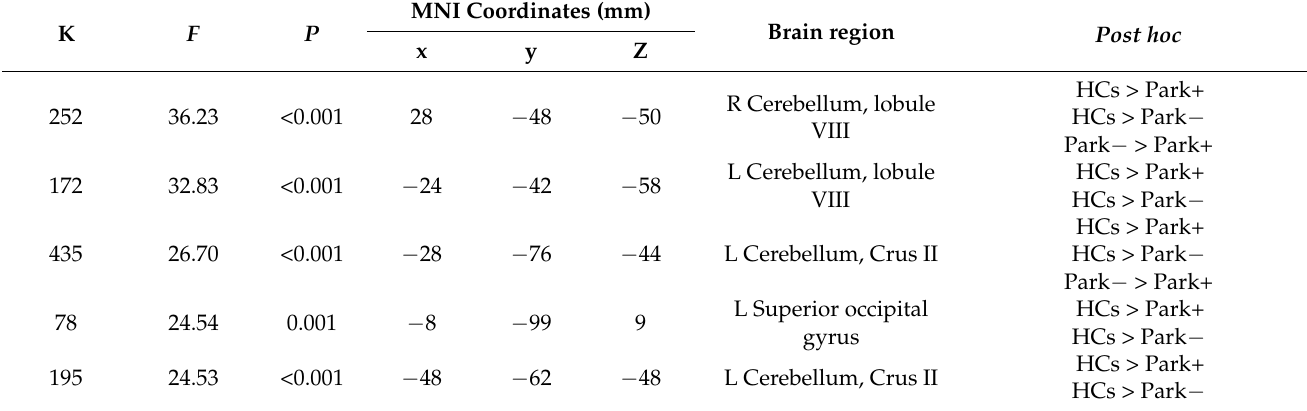
Table 2. Voxel-based morphometry (VBM) results comparing healthy controls (HCs) and 22q11.2DS patients with and without parkinsonism (Park+ and Park − ). Anatomical localization of significant ( p < 0.05 family-wise error-corrected, k ≥ 20 voxels) clusters was performed using the automated anatomical labeling toolbox of Statistical Parametric Mapping. L = left, R =